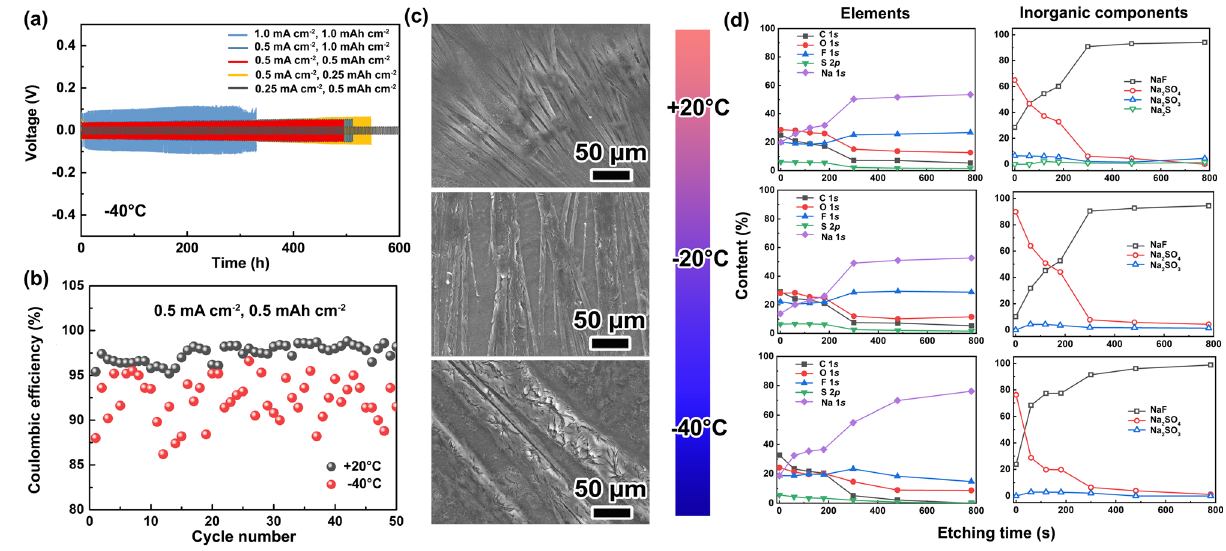
Fig. 2 | Electrochemical and physicochemical characterizations of Na metal electrodes cycled in 1M NaOTf-DEGDME at various temperatures. a Galvanostatic cycling of Na||Na symmetric cells at current densities up to 1.0mAcm − 2 with capacities up to 1.0mAh cm − 2 at − 40°C. b CE as a function of cycle number for Na||stainless steel cells at 0.5mAcm − 2 and 0.5mAh cm − 2 at